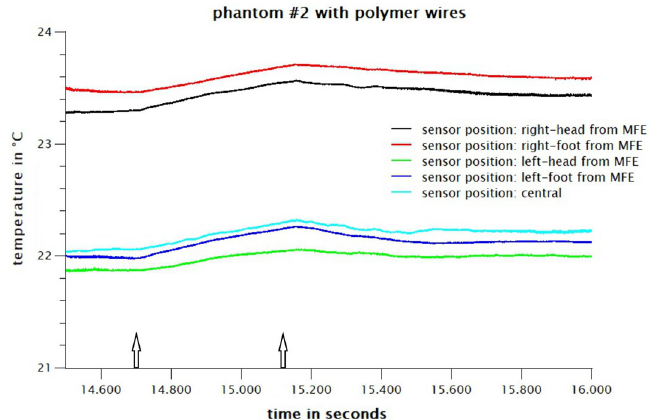
Figure 14. Heating effect of MRI on a polymer electrode with polymer cable loop. The central temperature sensors serves as control. No MRI induced heating can be observed. The image sequence starts at second 14.700 for 7 min and 26 s. The beginning and the end of the respective measuring sequence are marked with an